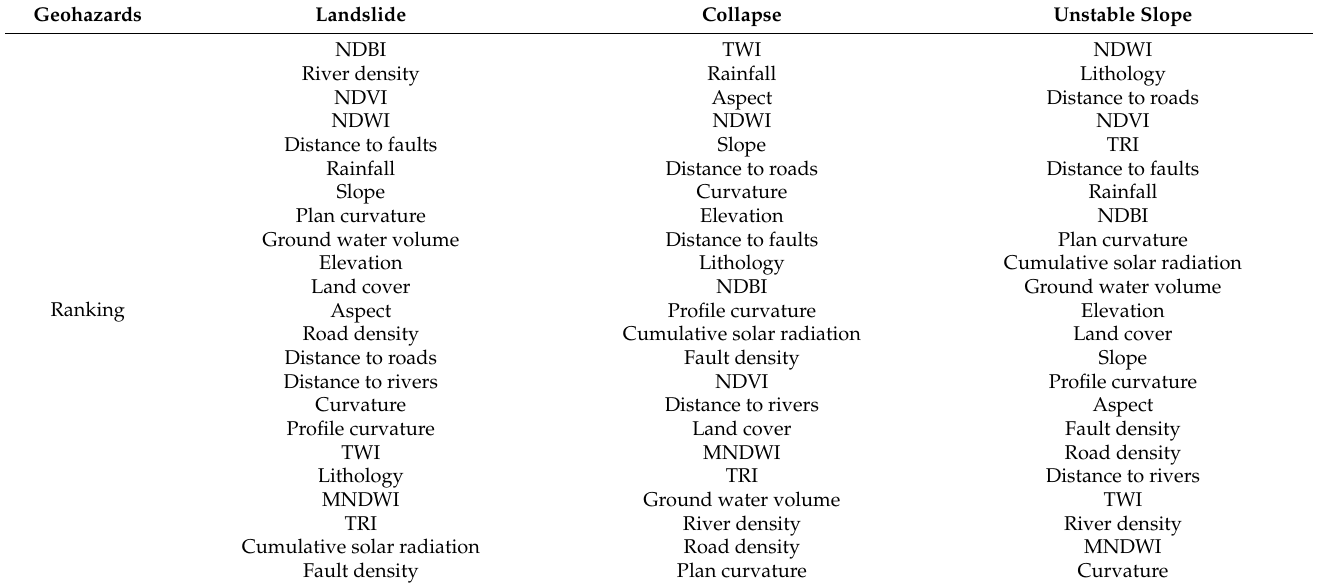
Figure 10. AUC changing curves of the wrapper-MDA feature selection method: ( a ) Landslide; ( b ) Collapse; ( c ) Unstable slope. The ranking results are shown in Table 10. Table 10. Relative ranking results of feature importance using the wrapper-MDA feature selection method.